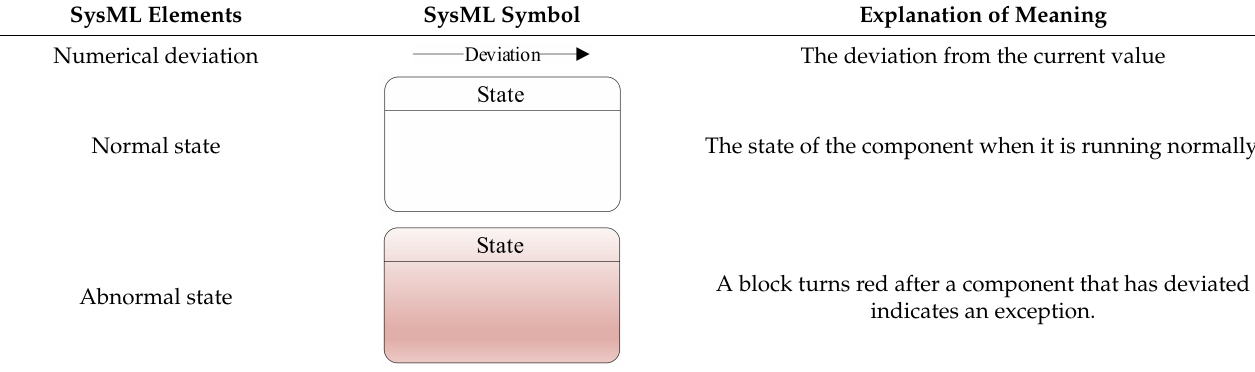
Table 4. The extended elements of